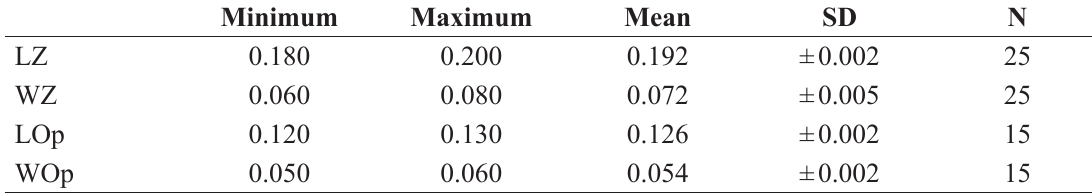
Table 1. Measurements in mm of Canda ukirensis sp. nov., holotype (GIS/B 0431), Burdigalian, lower Miocene, Chhasra Formation, western Kachchh, Gujarat, India. Abbreviations: see Material and